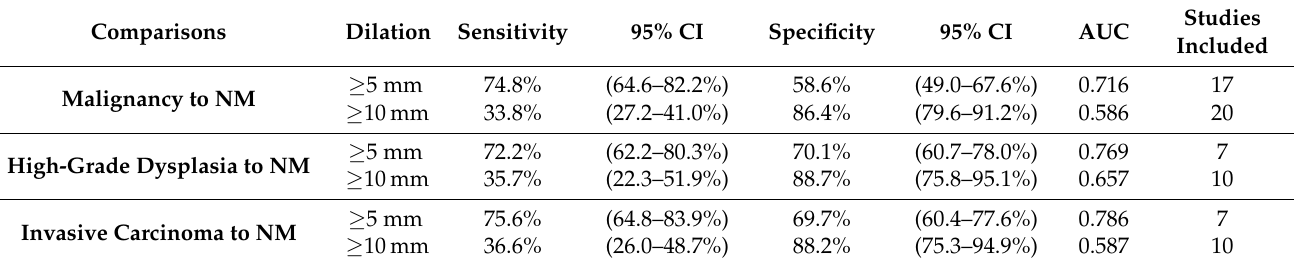
Figure 2. Meta-analysis forest plot presented in Diagnostic Odds Ratio (OR): ( A ) malignancy (M) and non-malignancy (NM), cutoff of 5 mm; ( B ) malignancy (M) and non-malignancy (NM), cutoff of 10 mm; ( C ) high-grade dysplasia (HGD) and non-malignancy (NM), cutoff of 5 mm; ( D ) high-grade dysplasia (HGD) and non-malignancy (NM), cutoff of 10 mm; ( E ) invasive carcinoma (IC) vs. non-malignancy (NM), cutoff of 5 mm; ( F ) invasive carcinoma (IC) vs. non-malignancy (NM), cutoff of 10 mm. Table 3. Pooled sensitivity/specificity and area under the curve